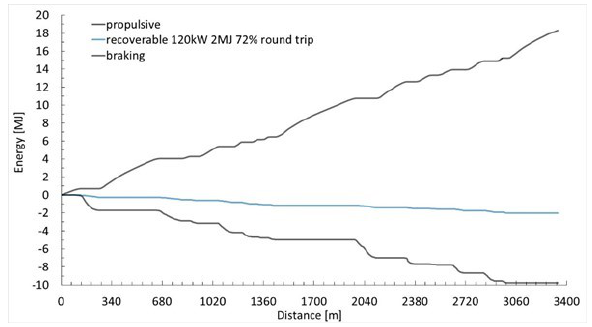
Fig. 6: Propulsive and braking energy